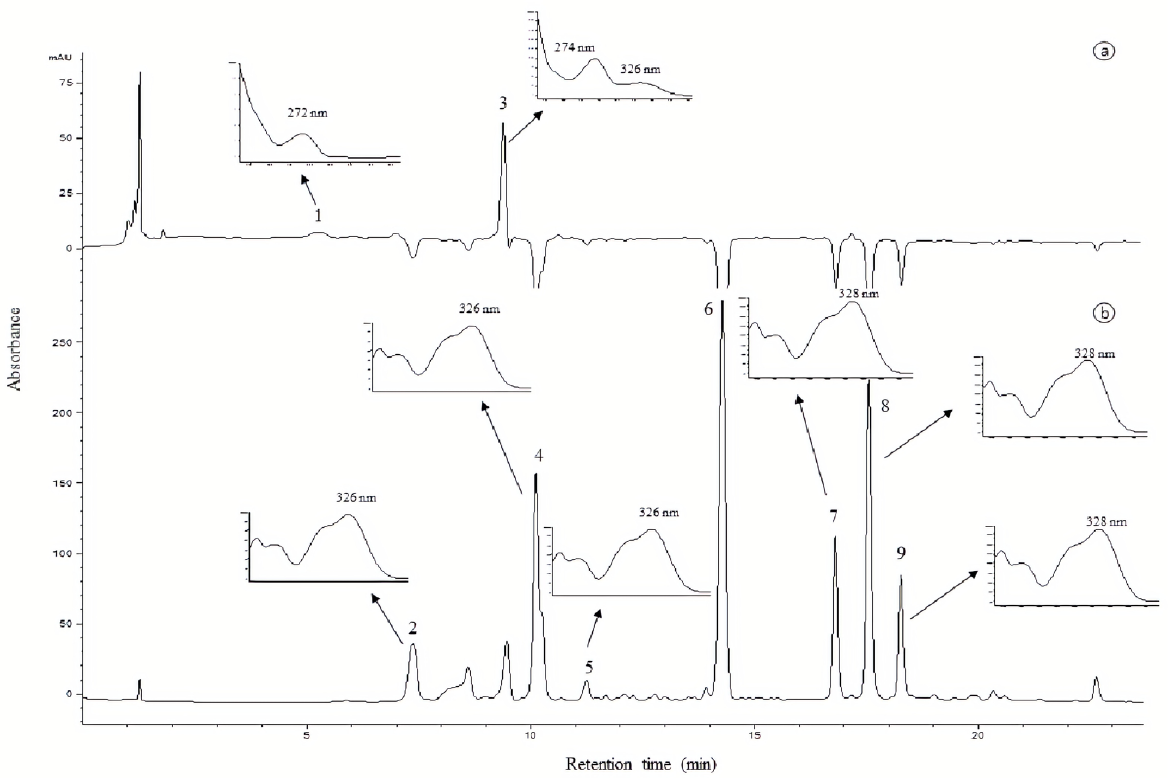
Figure 4. Typical HPLC chromatogram for I. paraguariensis callus extract. a) The UV spectra was 260 nm for caffeine and theobromine and b) 328 nm for caffeic acid derivatives. Peaks: (1) theobromine; (2) neochlorogenic acid; (3) caffeine; (4) chlorogenic acid; (5) cryptochlorogenic acid; (6) Internal standard umbelliferone; (7) 3,4-dicaffeoylquinic acid; (8) 3,5-dicaffeoylquinic acid; and (9) 4,5-dicaffeoylquinic